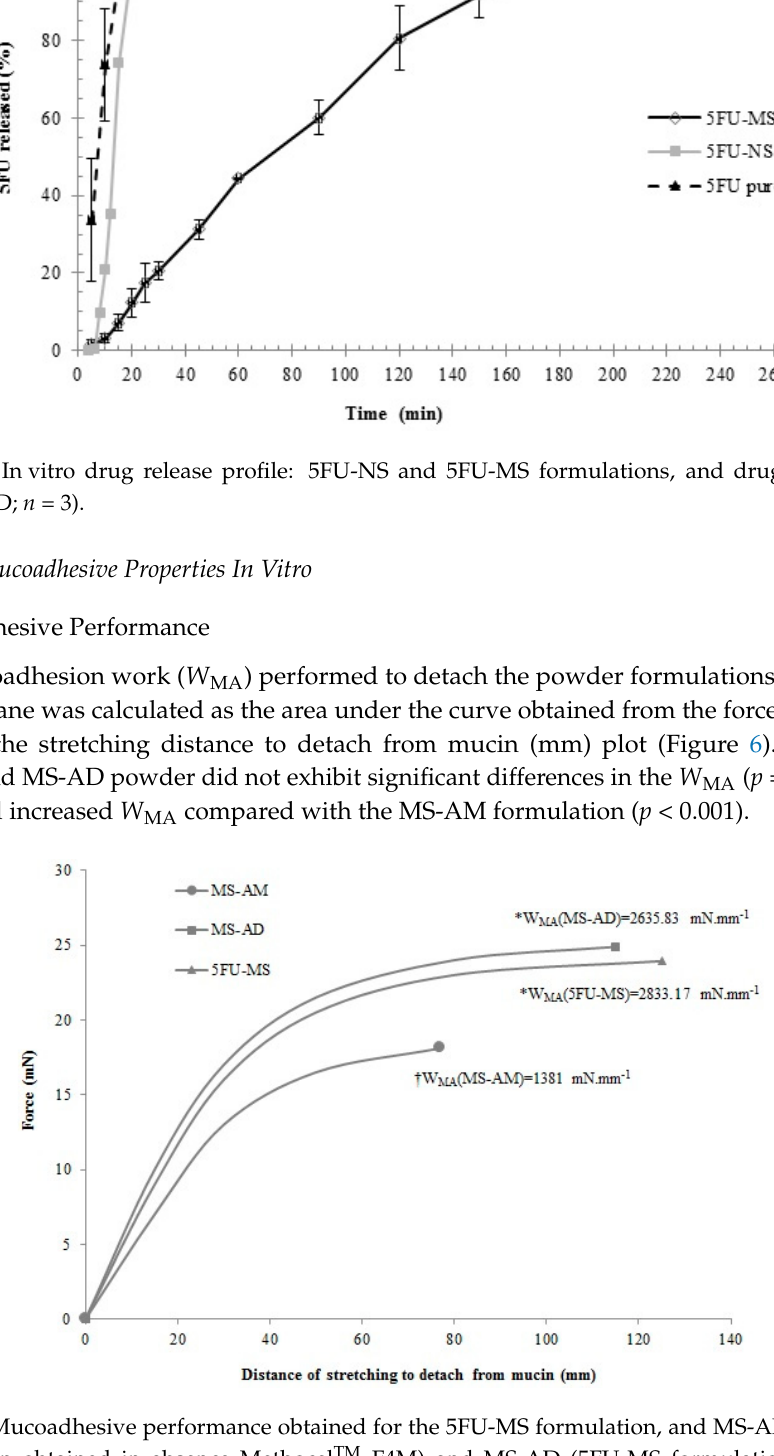
Figure 6. Mucoadhesive performance obtained for the 5FU-MS formulation, and MS-AM (5FU-MS formulation obtained in absence Methocel TM F4M) and MS-AD (5FU-MS formulation obtained in absence of drug) powders, determined by the Force (mN) of the detachment from the mucin membrane versus Distance traveled (mm). The area under the curve represents the Mucoadhesion Work ( W MA —mN·mm − 1 ) (mean ± SD, n = 3; * No significant difference; † Significant difference of * ).